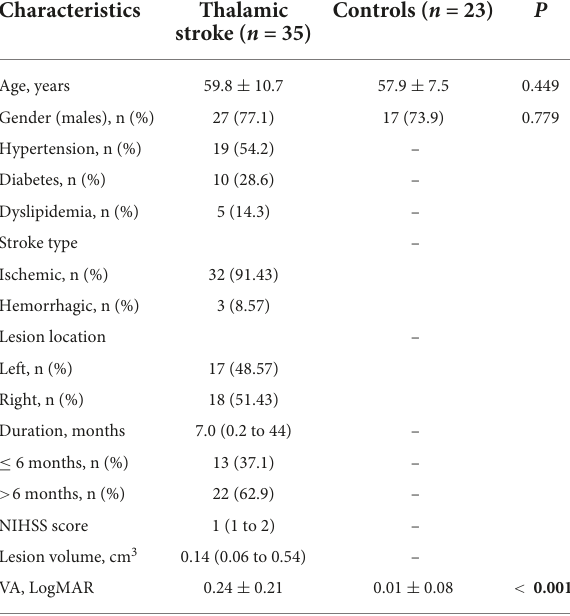
TABLE 1 Baseline demographic and clinical characteristics of all included